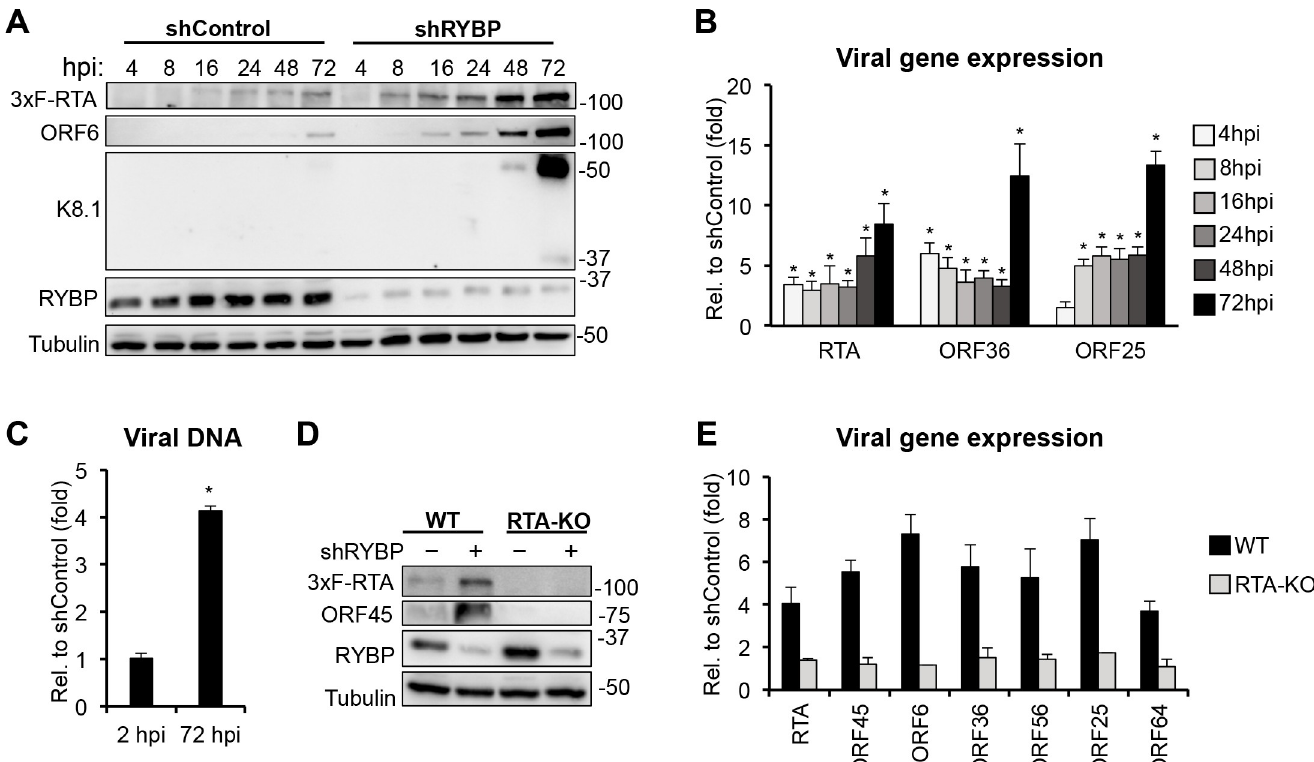
Fig 2. RYBP inhibits KSHV lytic genes during de novo infection, which are dependent on RTA expression. (A-B ) shControl- and shRYBP-treated SLK cells were infected with BAC16-3xFLAG-RTA KSHV for 4, 8, 16, 24, 48, and 72 hours. (A) Immunoblot analysis of RYBP and viral protein expression. (B) RT-qPCR analysis of viral gene expression. The relative fold change represents the induction of viral gene expression in shRYBP-treated cells relative to shControl-treated cells at different time points of KSHV infection. (C) Viral DNA level at 72 hpi was measured by qPCR, normalized to the host DNA level, and then calculated relative to 2 hpi in shControl- and shRYBP-treated SLK cells. (D-E) shControl- and shRYBP-treated SLK cells were infected with wild-type (WT) and RTA knockout (RTA-KO) KSHV for 72 hours. (D) Immunoblots analysis of RYBP and viral protein expression. (E) Measuring viral gene expression by RT-qPCR. The relative fold change represents the induction of viral gene expression in shRYBP-treated cells relative to shControl-treated cells.